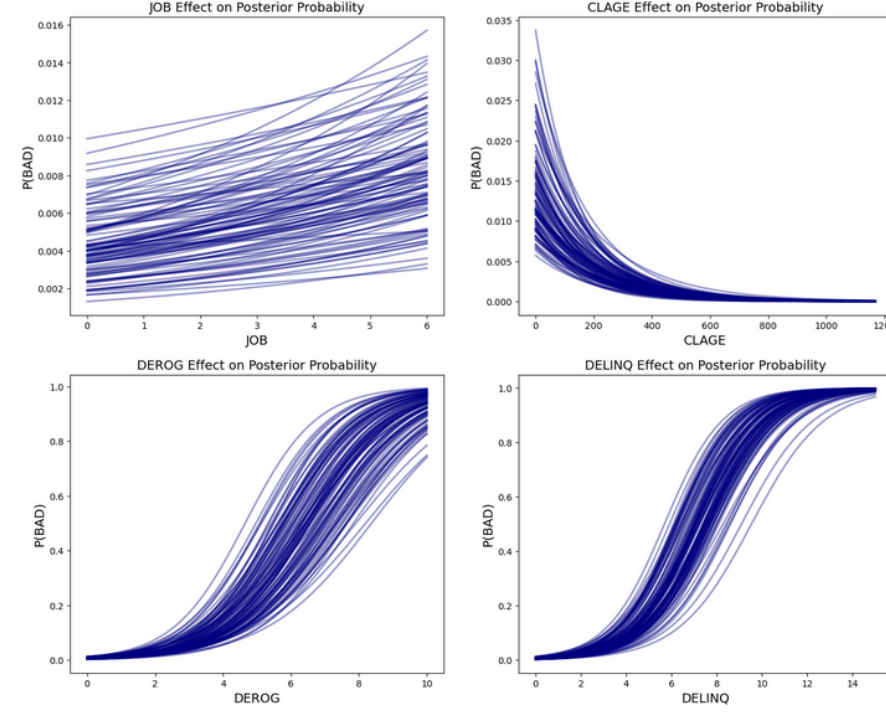
Figure 11. Variables effect on posterior probability.